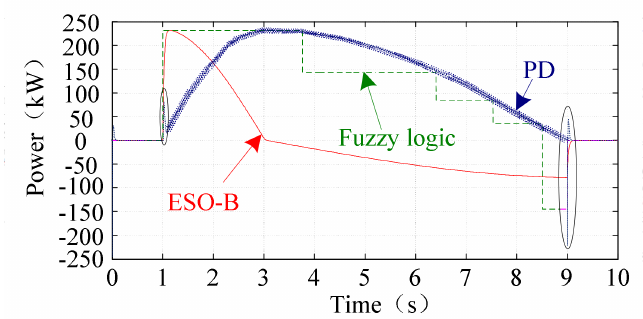
Figure 4. Comparison of proportional-derivative (PD) control, fuzzy logic control and ESO-B result for power grid frequency inertia